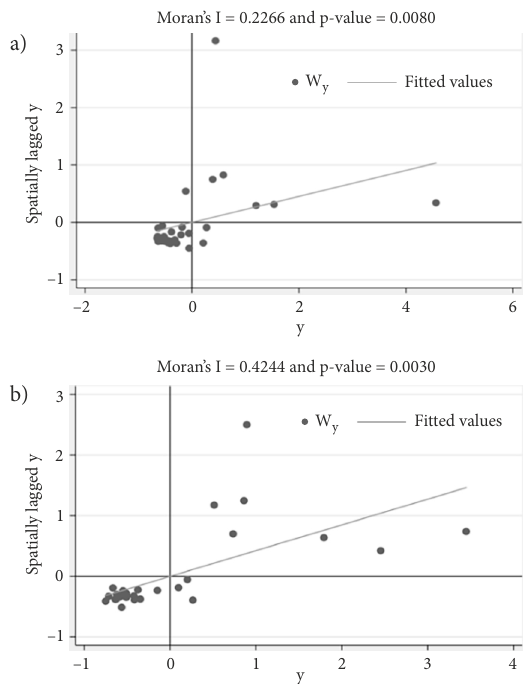
Figure 8. Local Moran scatter plot of DDE in 2010 (a) and 2019 (b) years Table 5. Characteristics of DDE space in 2010 (source: compiled by the authors) Quadrant Spatial